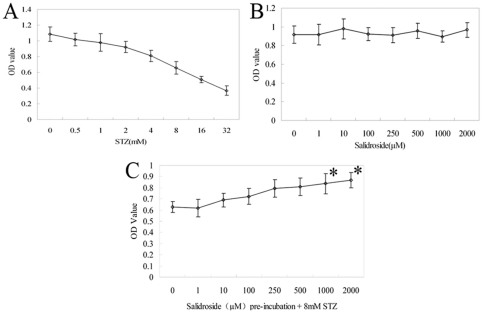
Viability of NSCs, as assayed by the MTT, at various doses of STZ and salidroside.(A) Cells from neurospheres at the second passage were incubated with various concentrations of STZ for 4 hr. STZ exhibits a dose-dependent cytotoxic effect on NSCs. (B) Salidroside at a concentration up to 2 mM for 12 hr shows no cytotoxic effects on NSCs. (C) Cells from neurospheres were pre-incubated with various concentrations of salidroside for 12 hr before exposure to 8 mM STZ. Salidroside at 1 or 2 mM exhibits significant protection against STZ-induced cytotoxity on NSCs. *
p<0.05 compared with the control value without salidroside. Values are expressed as means±SD.